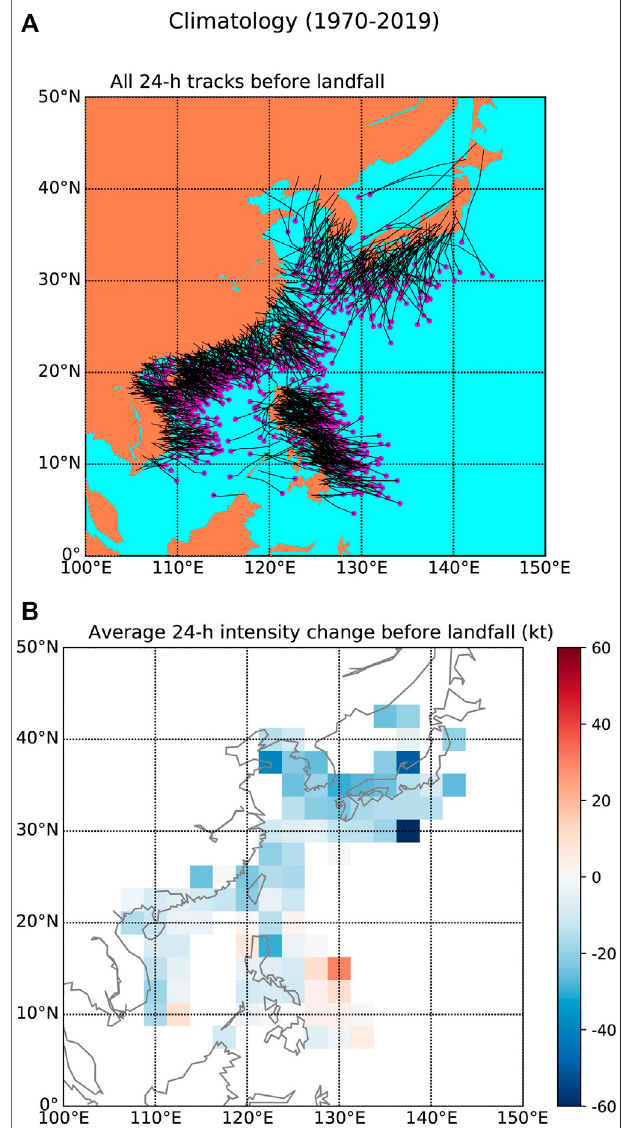
FIGURE 1 | (A) All 24-h tracks before landfall identi fi ed during JJASON from1970 – 2019usingJTWCbesttrackdata. (B) Climatologicalaverage Δ V 24 before landfall calculated over individual 2.5 ° × 2.5